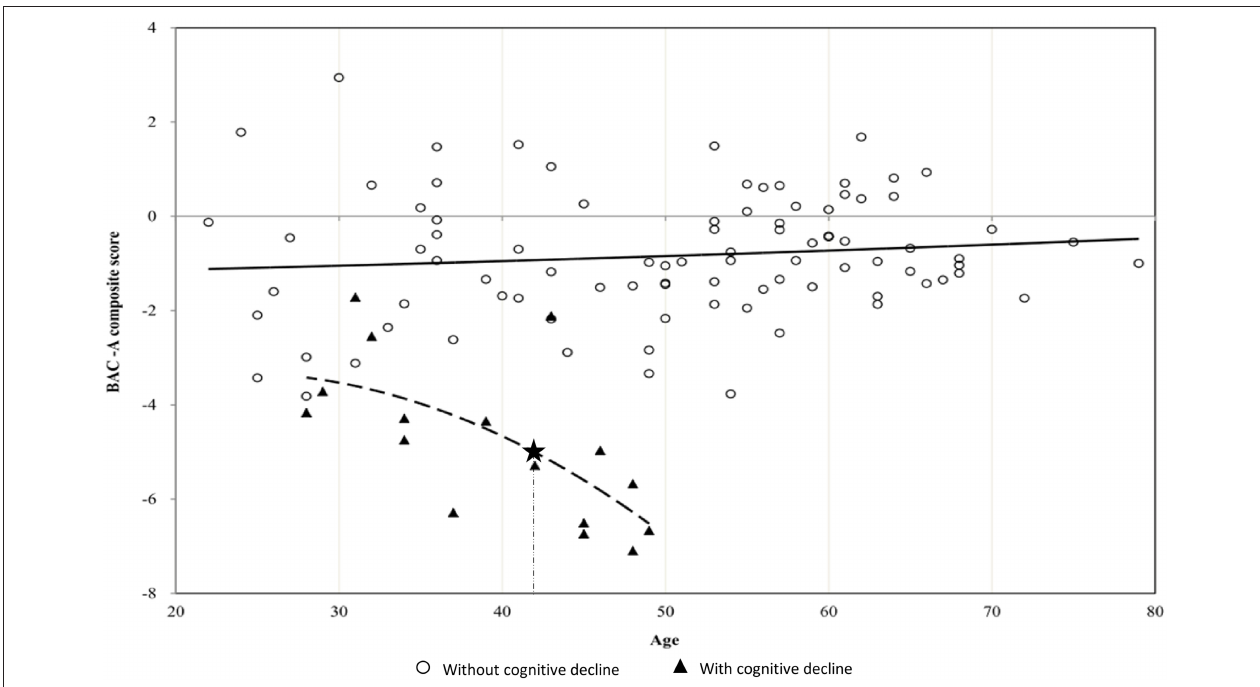
FIGURE 1 | Scatterplot between age and BAC-A composite score in BD patients with or without cognitive decline. The figure depicts steeper decrease in BAC-A composite score with hinge points (asterisk mark) at the age of 42 years in BD patients with cognitive decline. The slope of dotted curve showed − 0.276 SD per year after age